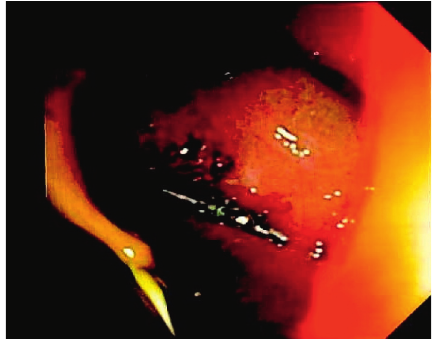
Figure 11: Closure of the tract by placing hemoclips.